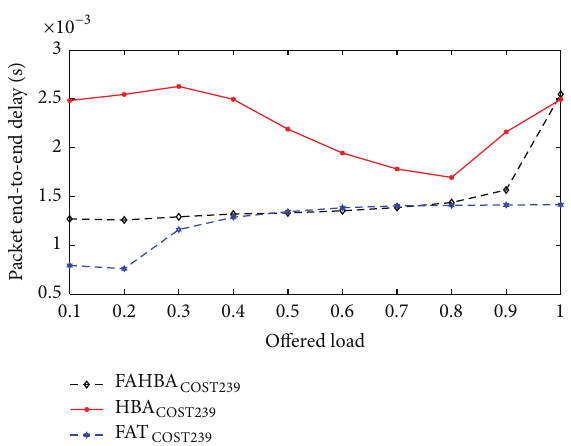
Figure 5: Packet end-to-end delay versus offered load.